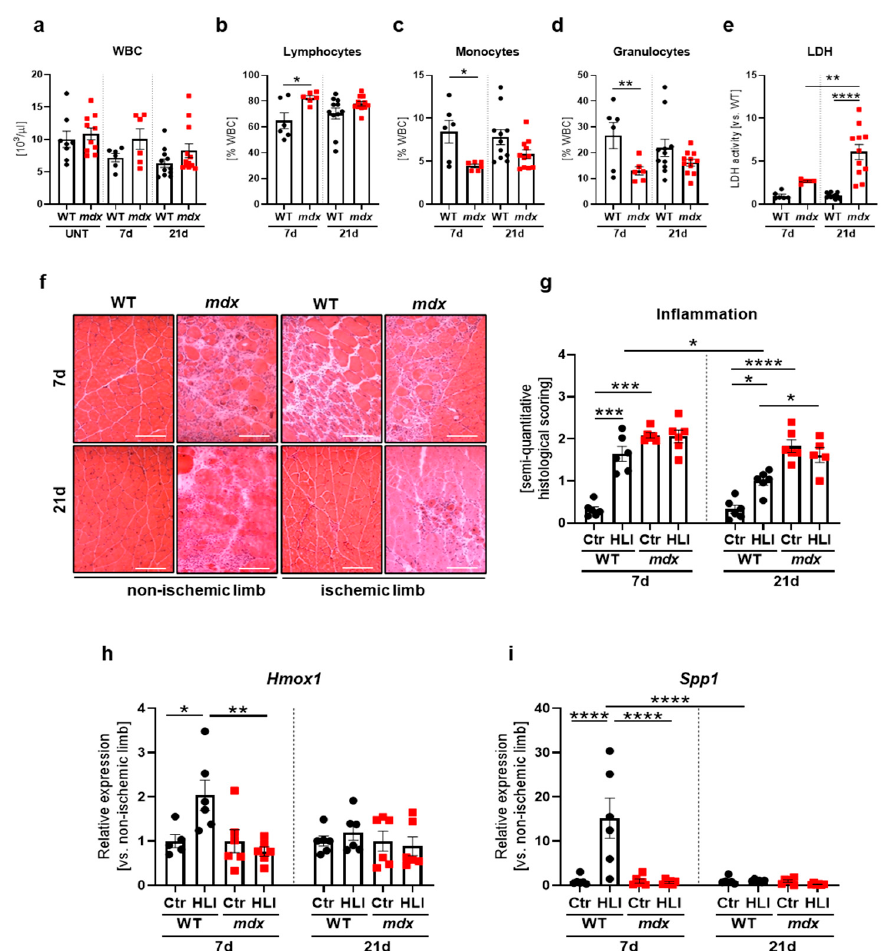
Figure 7. Inflammation markers following a hindlimb ischemia (HLI) procedure in 12-week-old dystrophic and WT animals. ( a ) The number of white blood cells (WBC) and ( b ) the percentage of lymphocytes, ( c ) granulocytes, and ( d ) monocytes assessed in the peripheral blood of WT and mdx mice, 7 and 21 days after HLI and in untreated (UNT) WT and mdx mice in case of WBC; blood cell count; n = 6–12/group. ( e ) Lactate dehydrogenase (LDH) release to serum analyzed 7 and 21 days after HLI in WT and mdx animals; activity assay; n = 6–12/group. ( f ) Representative pictures of hematoxylin and eosin staining of the gastrocnemius with ( g ) semi-quantitative histological scoring of inflammation in the non-ischemic and ischemic leg of WT and mdx mice, 7 and 21 days after HLI; microscopic assessment using a Nikon Eclipse microscope. Scale bar: 100 µ m; n = 5–6/group. The expression of ( h ) Hmox1 and ( i ) Spp1 in the gastrocnemius of WT and mdx animals 7 and 21 days after HLI; qRT-PCR; n = 5–6/group. The results are presented as mean ± SEM. * p < 0.05, ** p < 0.01, *** p < 0.005, **** p < 0.0001 by one-way ANOVA with Tukey’s posthoc test.